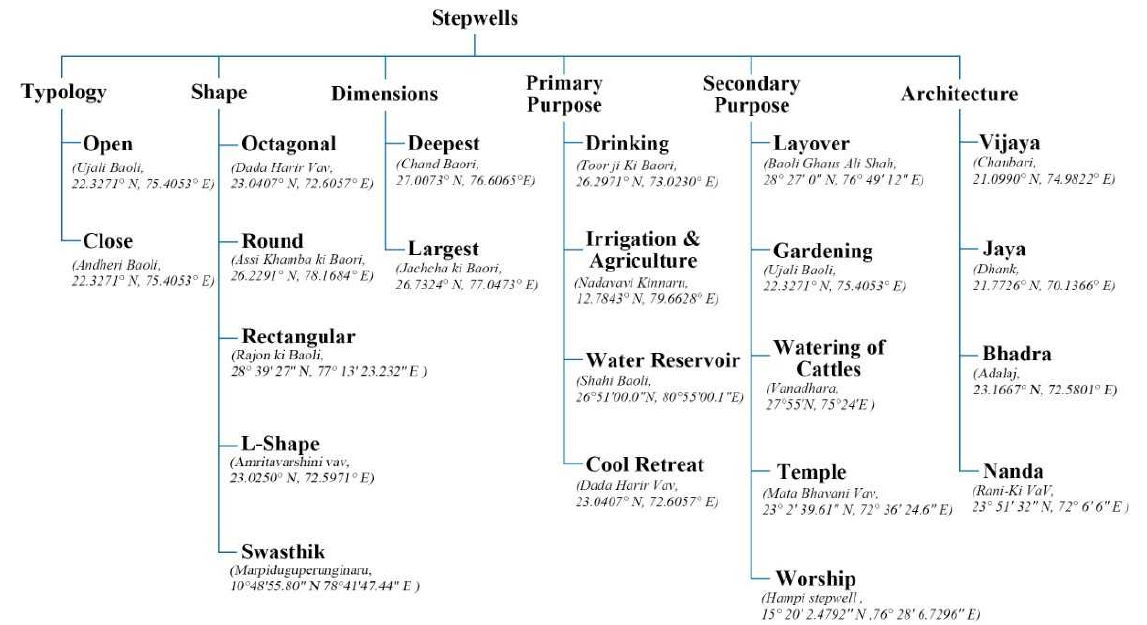
Figure 5. Broad classification of stepwells